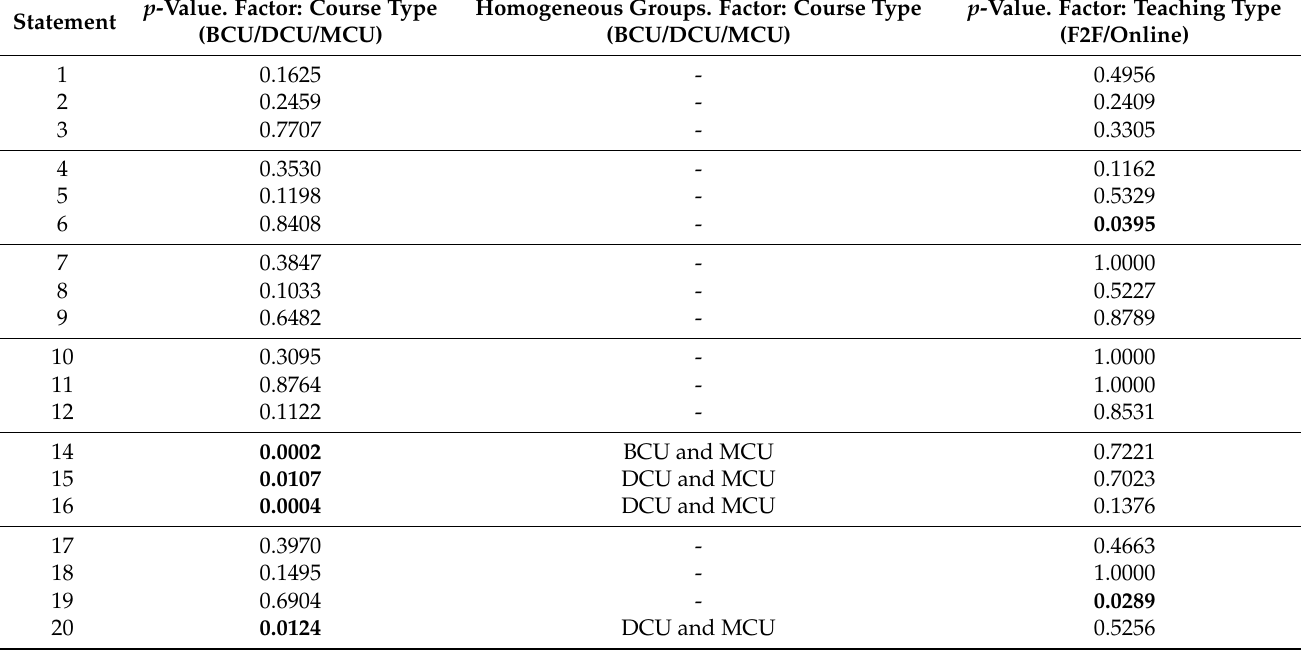
Table 2. Results of two-way